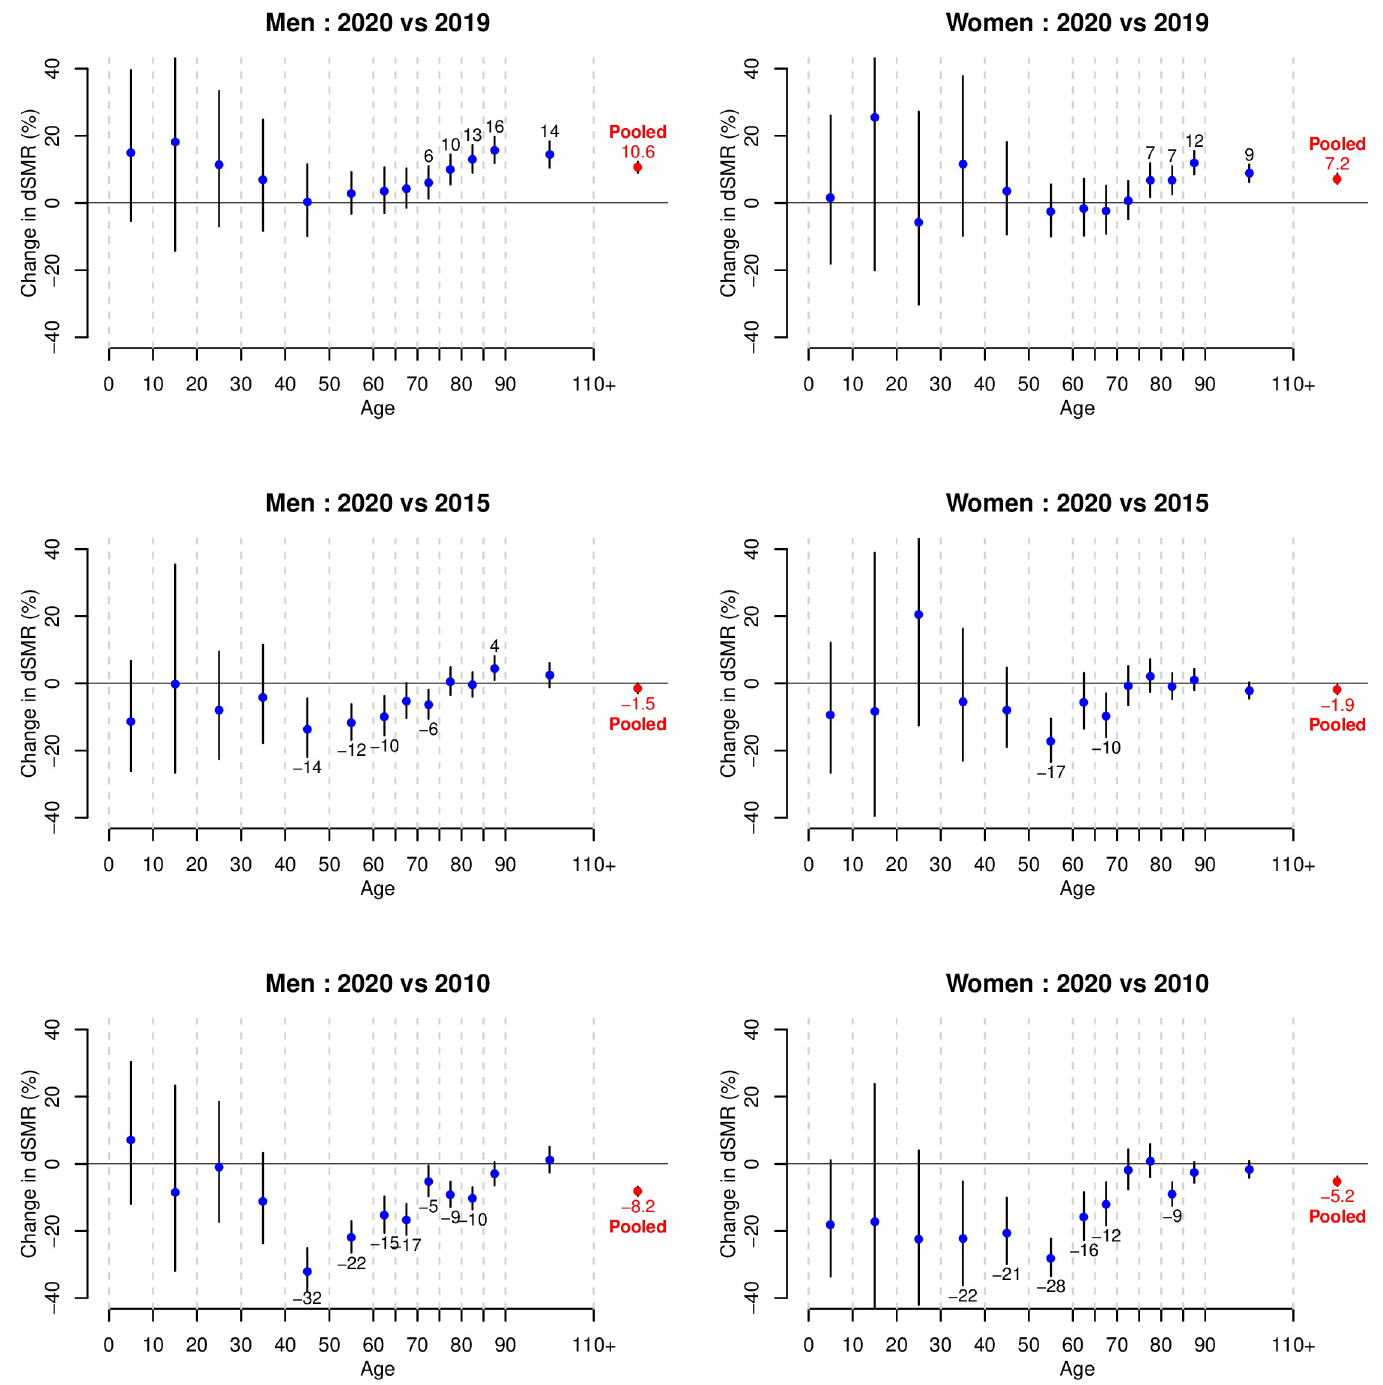
Fig 2. Relative change in directly standardized mortality rates (dSMR) when comparing 2020 with 2019, 2015 and 2010 in selected age groups, separately for men and women, as well as for pooled age classes, together with 95% confidence intervals. Estimated changes (expressed in %) are provided when statistically significant.